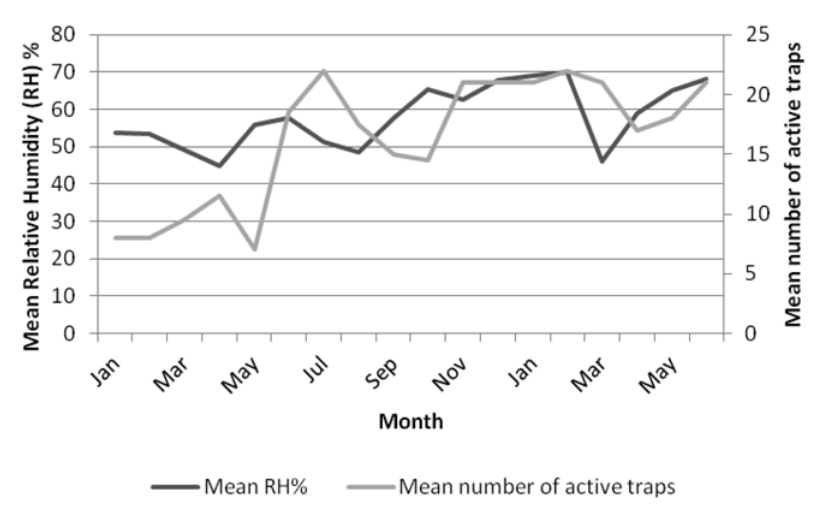
Fig. 5. Mean number of active collection traps (out of 22 total) at the C. gestroi field site in comparison to mean relative humidity from January 2010 –June